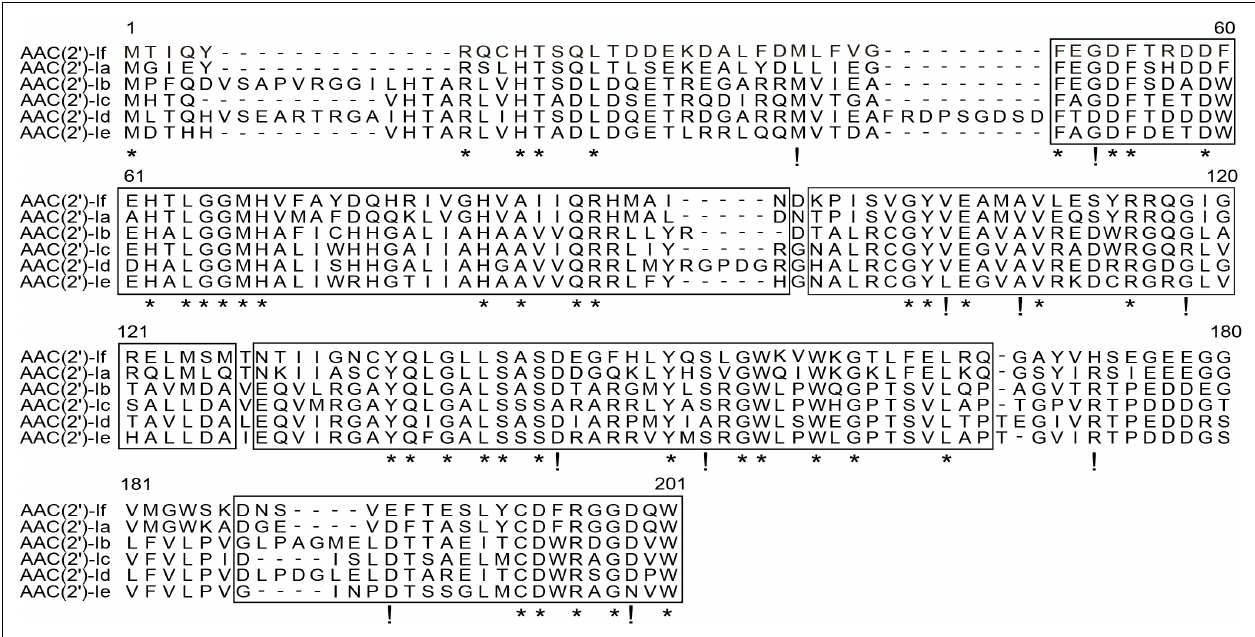
streptomycin), spectinomycin, polymyxins B and E, nalidixic acid, norfloxacin, chloramphenicol, florfenicol, cefoxitin, ceftiofur, imipenem, and